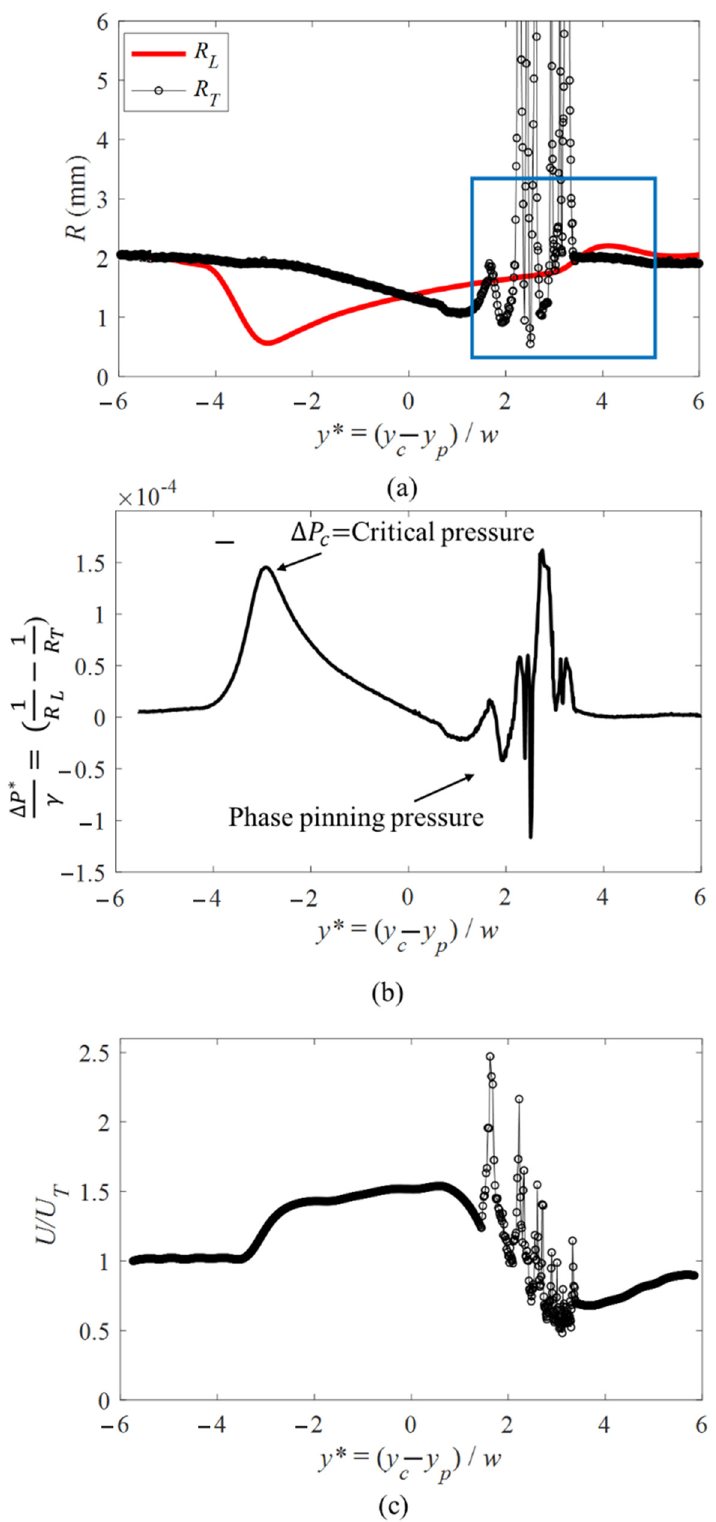
Figure 11. Plots of ( a ) change in the radii of curvature of leading and trailing edge of a bubble, ( b ) pressure along the bubble, and ( c ) velocity of the of the projected area of a bubble ( R b ∼ 1.95 mm) passing through a circular pore with 0.4 mm roughness on the surface (Sample images of different conditions are shown in Figure 6III).